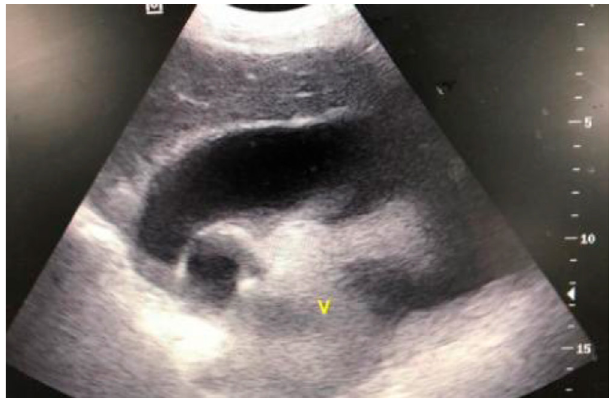
Fig. 1 – Pericardial effusion visualized in the trauma center during FAST.